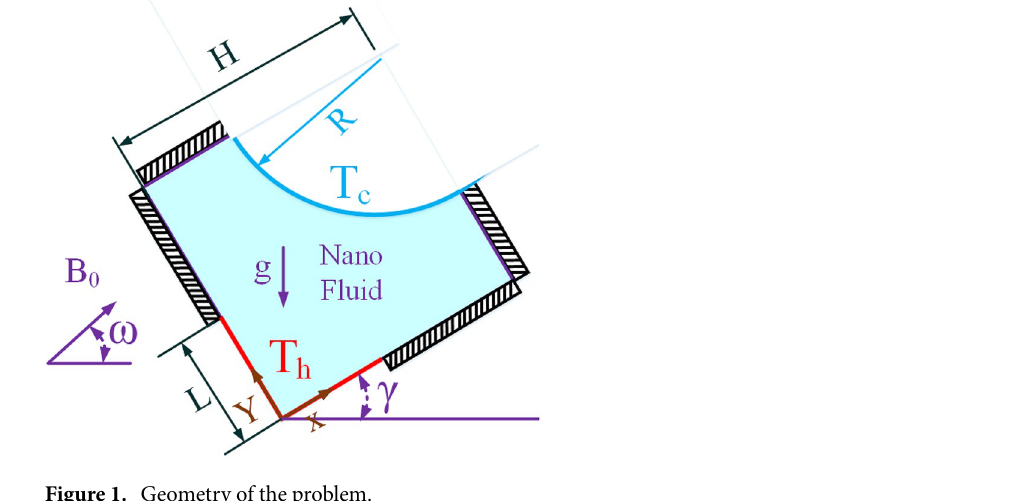
Figure 1. Geometry of the